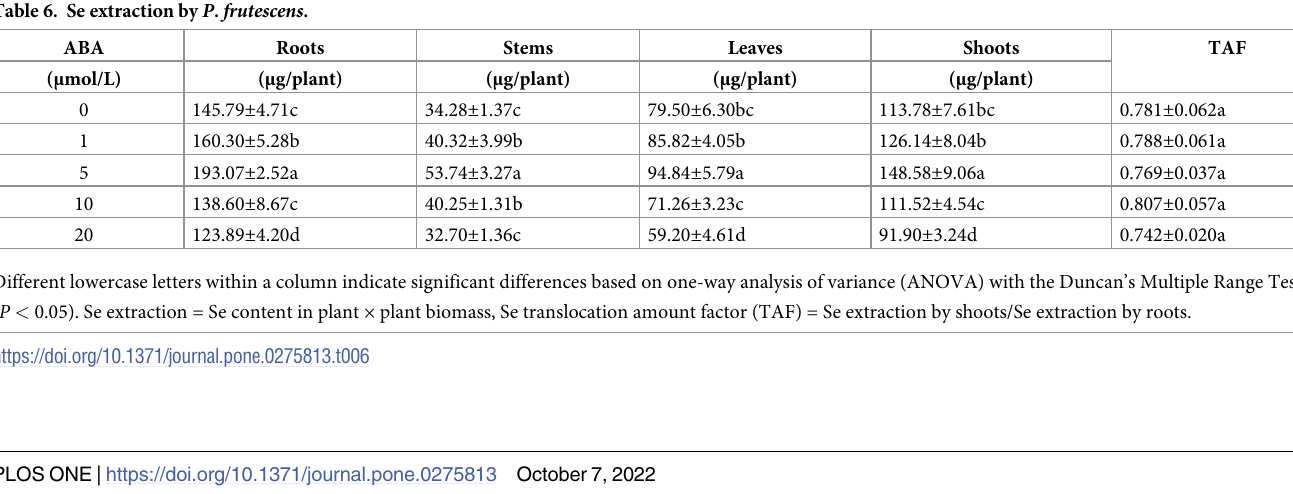
The findings showed that 1 and 5 μ mol/L ABA increased the Se extraction by roots of P . frutes- cens by 9.95%, and 32.43%, respectively, relative to the control, whereas other ABA concentra- tions had no effect ( P > 0.05) significant or decreased (Table 6). Administration of 1, 5, and 10 μ mol/L ABA increased the Se extraction by stems relative to the control, whereas use of 20 μ mol/L ABA showed no significant ( P > 0.05) effect. Notably, only 5 μ mol/L ABA increased the Se extractions by leaves and shoots by 19.30% and 30.59%, respectively, whereas other ABA concentrations had no significant ( P > 0.05) effect or decreased. Regression analysis showed that the root Se extraction had a linear regression relationship with ABA concentration (x: ABA concentration; y: root Se extraction; y = -1.853x + 165.674, R 2 = 0.320, P = 0.028), and the shoot Se extraction also had a linear regression relationship with ABA concentration (x: ABA concentration; y: shoot Se extraction; y = -1.648x + 130.249, R 2 = 0.381, P = 0.014). The results showed no significant ( P > 0.05) differences in the TAF of P . frutescens among the dif- ferent ABA concentrations.